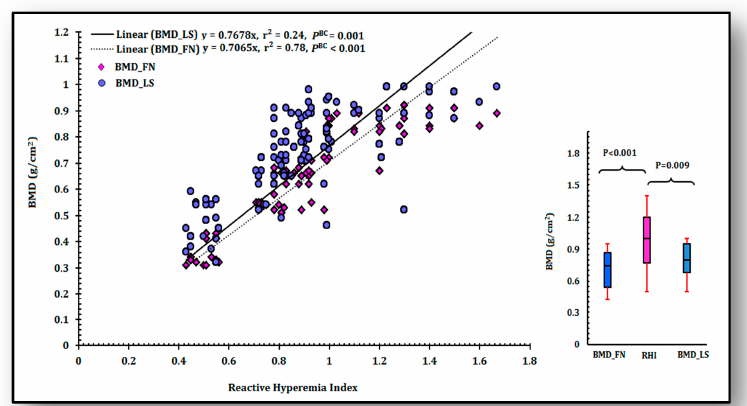
Figure 2. Linear regression analysis between bone mineral density (BMD_FN and BMD_LS) and endothelial dysfunction (Reactive Hyperemia Index). p values are corrected with Bonferroni ( P BC ) for correlation coefficients (r 2 ). Box and whisker plots depict median values along with first interquartile and third interquartile values. BMD_FN: bone mineral density at femoral neck, BMD_LS: bone mineral density at lumbar spine, RHI: reactive hyperemia index. Several genotype specific single marker effects within SNPs of eNOS, ACE and VEGFA genes on risk covariates were deduced. All significant single marker effects ( p < dent of osteoporosis risk. Functional SNP of eNOS gene; rs2070744 showed epistatic re- lationship with SNPs rs4343, rs1799983, rs1800764 and rs891512 influencing RHI ( p = 0.001), LDL ( p = 0.005), TG (0.001) and SBP ( p = 0.003) through interactive (I), additive x additive (AA), dominant × additive (DA) and additive × dominant (AD) modes respec- tively. Interestingly, SNP pairs rs2070744-rs1800764 impacted TG through DA mode in control subjects ( p = 0.041) also. Another SNP pairs which showed impact on the risk of osteoporosis through AA, dominant × dominant (DD) and I mode were rs4343-rs2010963 ( p = 0.009), rs1800764-rs1799752 ( p = 0.029) and rs1799983-rs891512 ( p = 0.032) influencing RHI, TC and RHI respectively. Similarly, SNP rs1799983 coupled with rs699947 ( p = 0.001), rs699947 with rs1799752 ( p = 0.003) and rs891512 with rs1799752 ( p = 0.022) to in- fluence BMI, RHI and LDL through DD, I and DA modes, respectively. SNP pair rs1799983-rs699947 was observed to afflict DD influence in women without osteoporosis also ( p = 0.041). Two locus SNP-SNP epistatic links without risk variables have been shown in figure embedded in the Table 6, to have quicker glance without some perplex interactions.